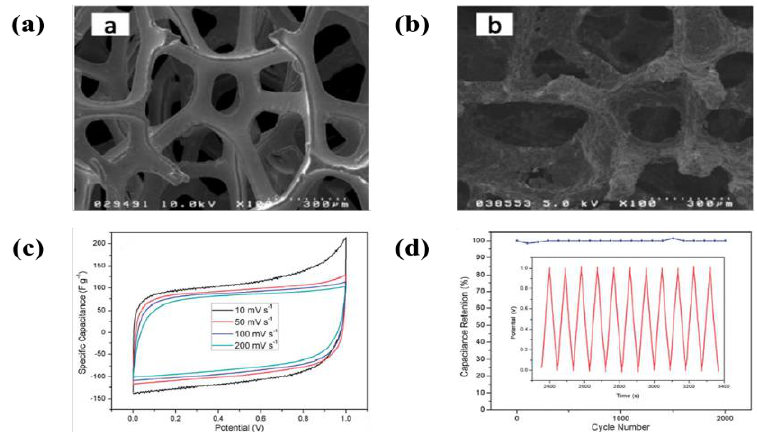
Figure 17. ( a ) SEM image of bare nickel foam; ( b ) SEM image of 3D porous graphene electrode